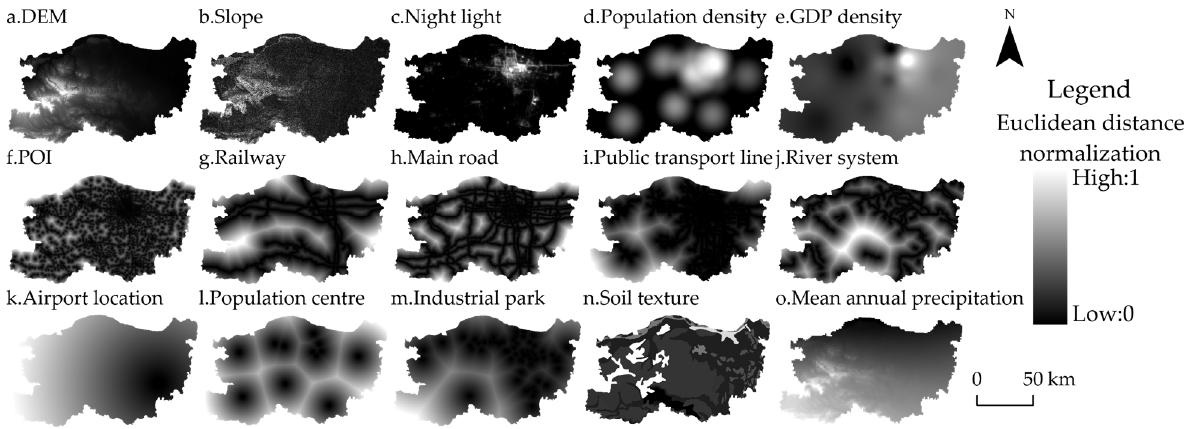
Figure 2. Land use drivers.